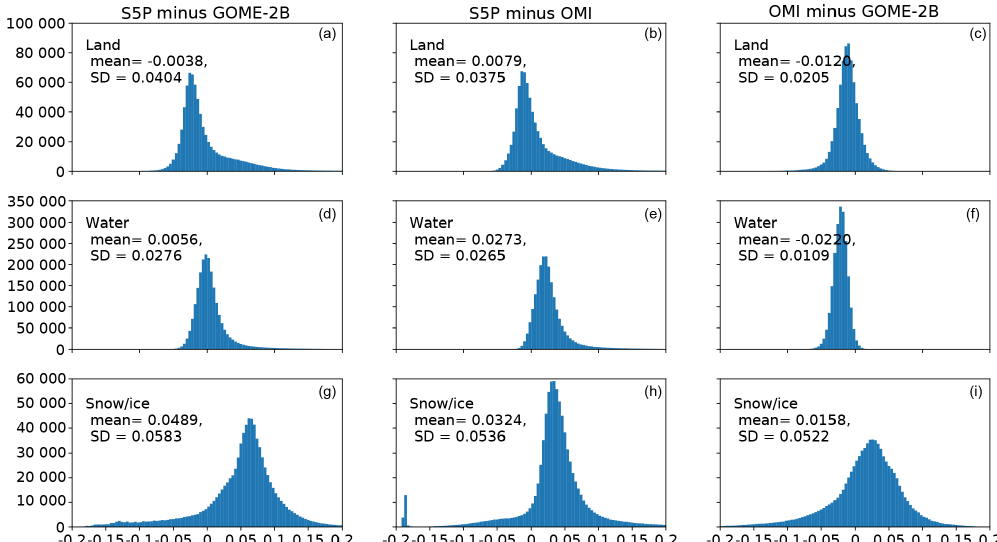
Figure 10. Histograms of the differences (a, d, g) between TROPOMI G3_LER and GOME-2B climatology, (b, e, h) between TROPOMI G3_LER and OMI LER climatology, and (c, f, i) between OMI and GOME-2B LER climatologies. The comparisons are performed sepa- rately for surface types (land, water, and snow/ice) using data from October